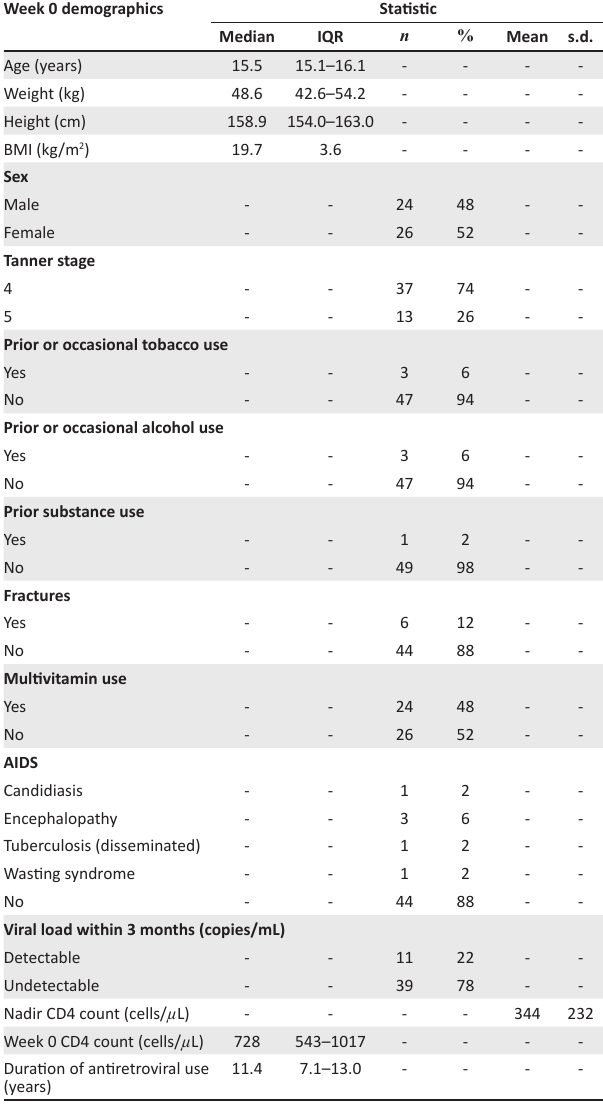
TABLE 1: Demographics for 50 virologically controlled ALWH switching to